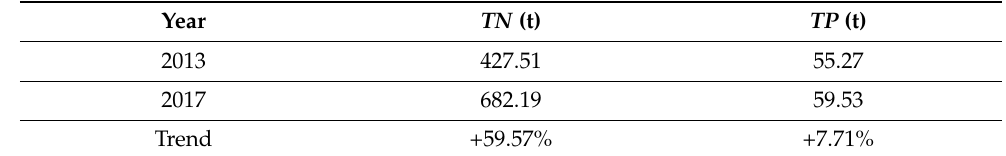
Table 4. TN and TP loads in four towns in 2013 and 2017.